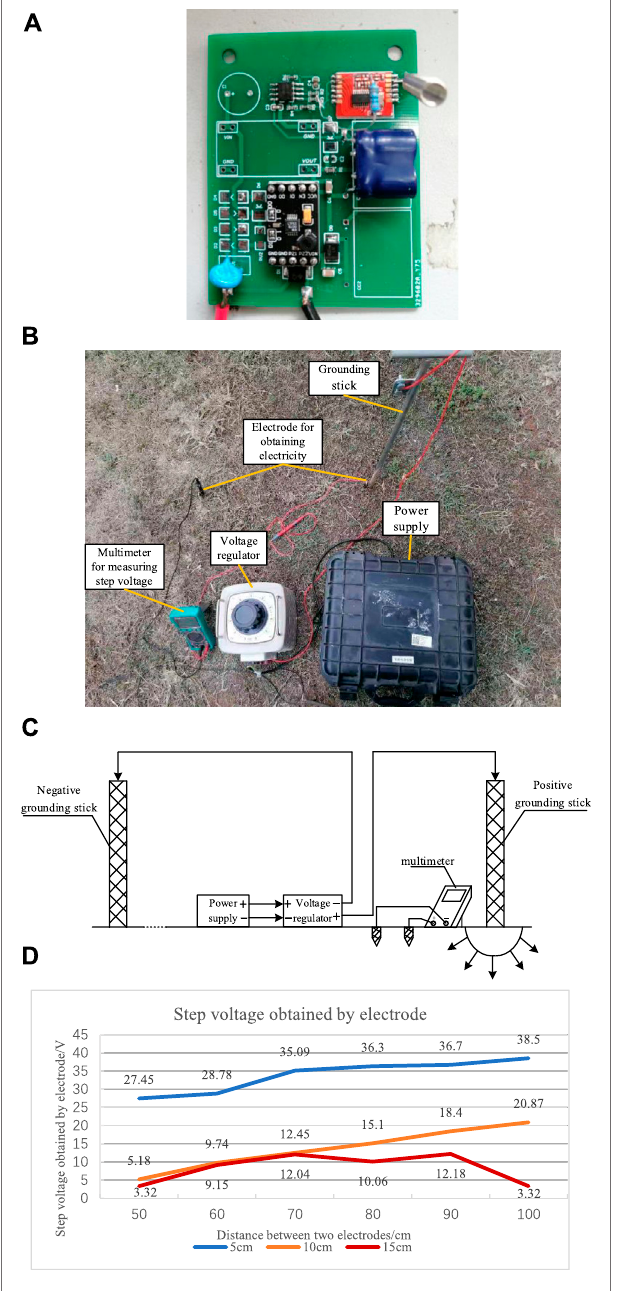
FIGURE 3 | Physical and experimental representation. (A) Physical diagram of the leakage energy extraction and early warning device. (B) Electrode laying position experiment. (C) Experimental block diagram of the electrode laying position. (D) Step voltage obtained by the electrode.